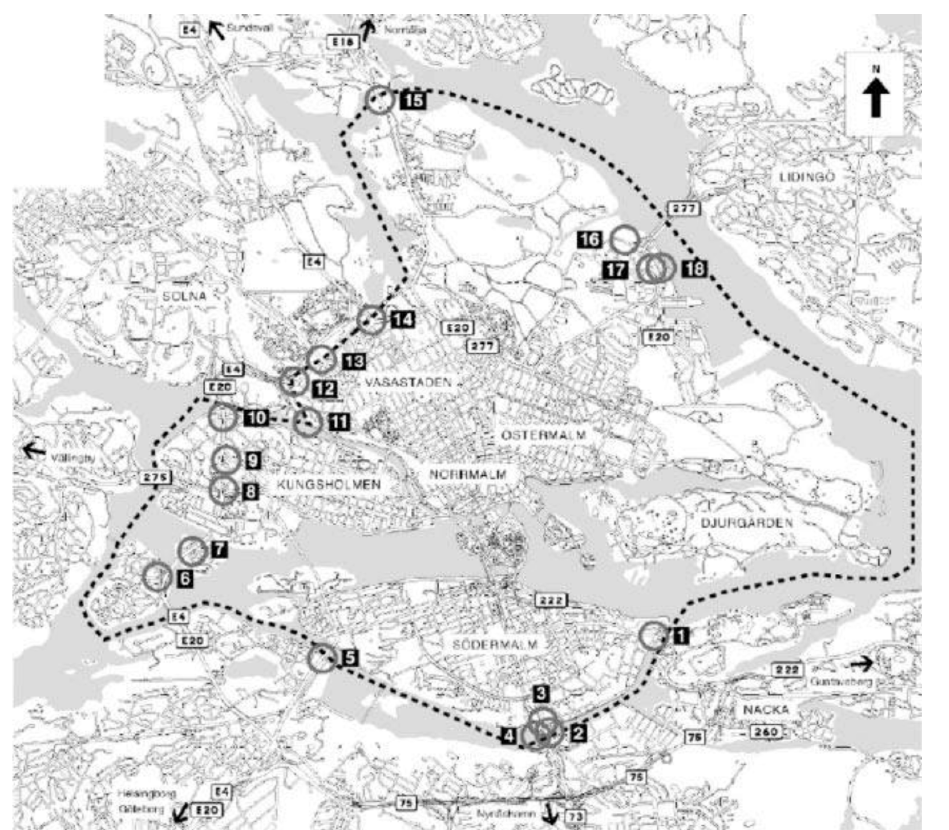
Figure 1. The congestion charge zone and electronic payment gateways. Many gateways have several hundred years of history as tolled entry points for goods into the city. It is also no accident that all of the actual charging points (including the physical infrastructure itself) are on Stockholm City land. To site gateways in other municipalities would have required negotiating land use rights with additional communities and it was feared that surrounding municipalities could use land use monopoly power to block the trial (Hårsman & Quigley, 2010; Swedish Road Administration,